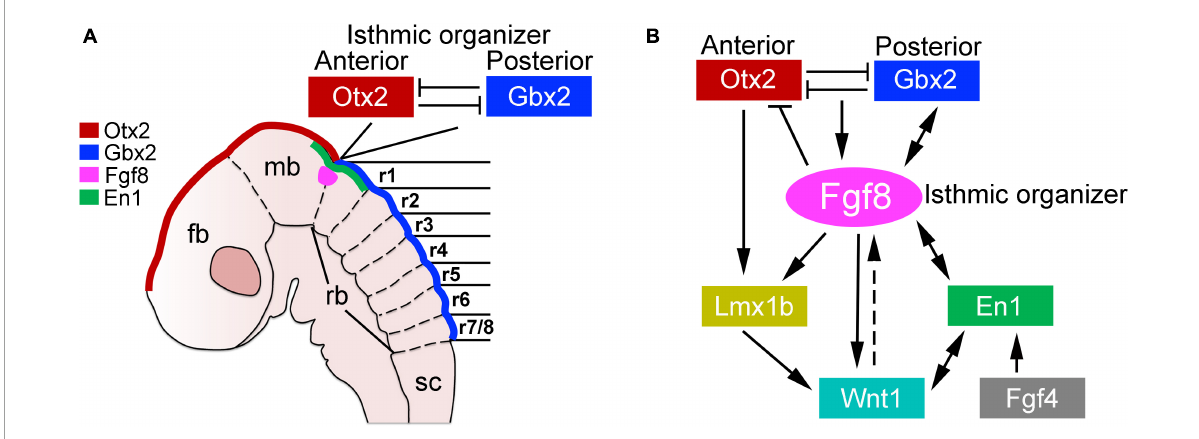
FIGURE1 Development of the midbrain-hindbrain border. (A) Schema illustrating the molecular and anatomical establishment of the anterior and posterior brain regions by the expression of Otx2 and Gbx2 , respectively, in a developing mouse embryo (between E8-E8.5). The forebrain (fb), midbrain (mb), rhomboencephalon (rb), and spinal cord (sc) are indicated. The transient morphological segments of the rhombencephalon (rhombomeres, r) are also illustrated. (B) Molecular networks acting in the midbrain–hindbrain border for the establishment of the isthmic organizer (see the text). This figure is adapted from our previous publication Lowenstein et al. (2022) that was published under the terms of the Creative Commons Attribution License, which permits unrestricted use and redistribution, provided that the original author and source are credited